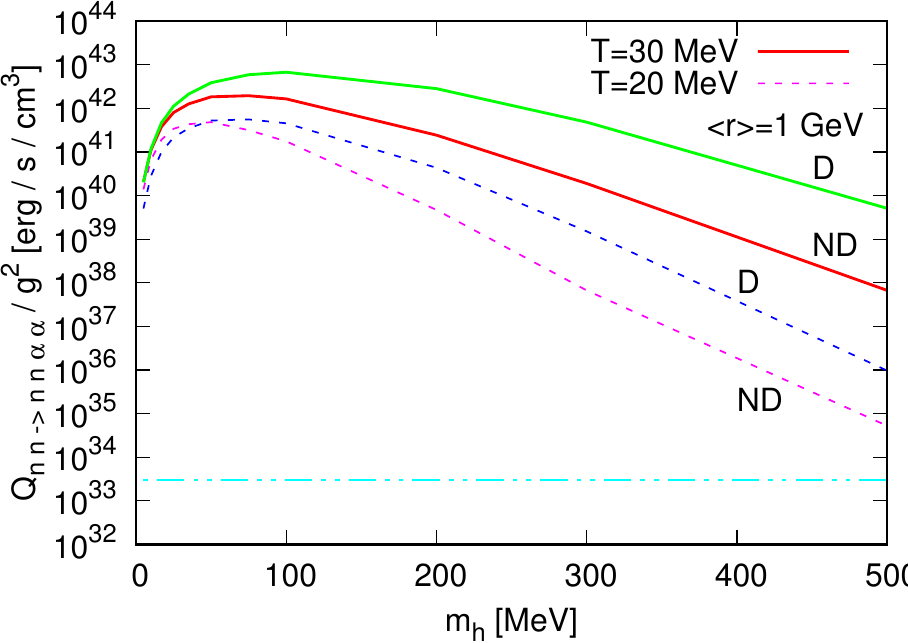
Figure 2 . Energy loss rate due to Goldstone boson emission from nuclear bremsstrahlung processes nn ! nn(cid:11)(cid:11) divided by the Higgs portal coupling g 2 , for various light Higgs boson mass m h . The rates are calculated in the non-degenerate (ND) and degenerate (D) limits, for proto-neutron star core temperature T = 30 MeV (solid) and 20 MeV (dashed), respectively, and neutron fraction X n = 1. For all m h values we assume the radial (cid:12)eld vacuum expectation value is h r i = 1 GeV. Also shown is Ra(cid:11)elt’s analytical criterion on the energy loss rate per unit volume Q X in eq. (5.1)